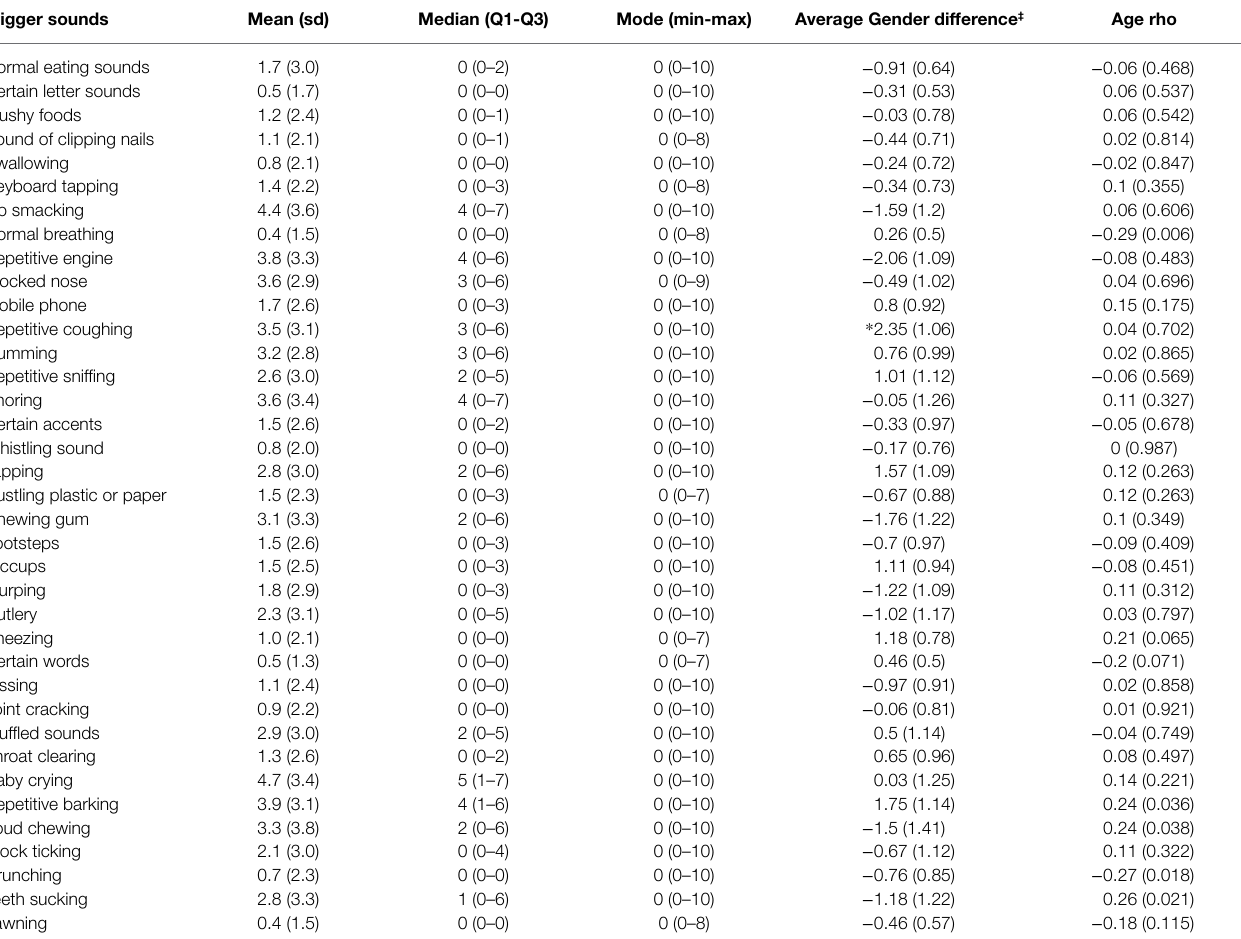
TABLE 6 | Norms and reliability of the intensity items for the 37 S-Five-T sounds. Trigger sounds Mean (sd) Median (Q1-Q3) Normal eating